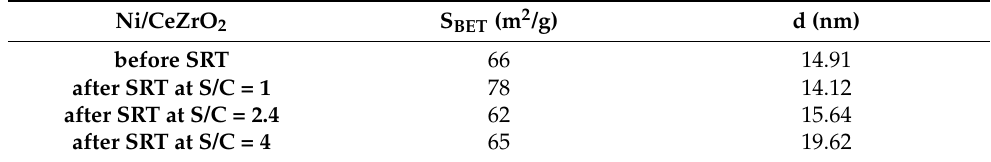
Table 3. The textural properties of Ni/CeZrO 2 before and after catalytic runs of SRT.